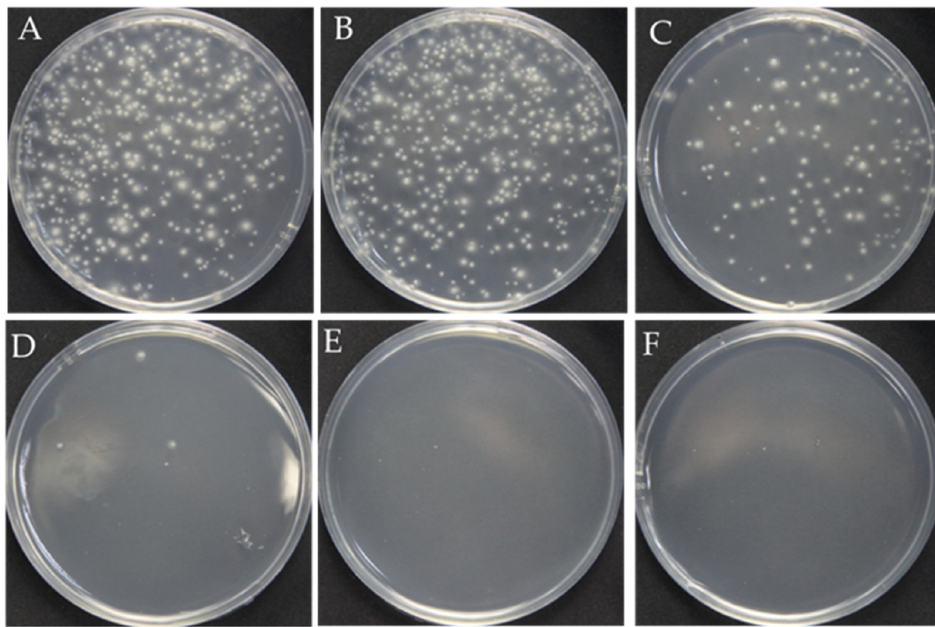
Figure 1. Effect of the Triton X-100 on the protoplast regeneration. ( A – F ): The different concentra- tions of Triton X-100: 0, 0.005%, 0.01%, 0.15%, 0.2%, 0.3%,